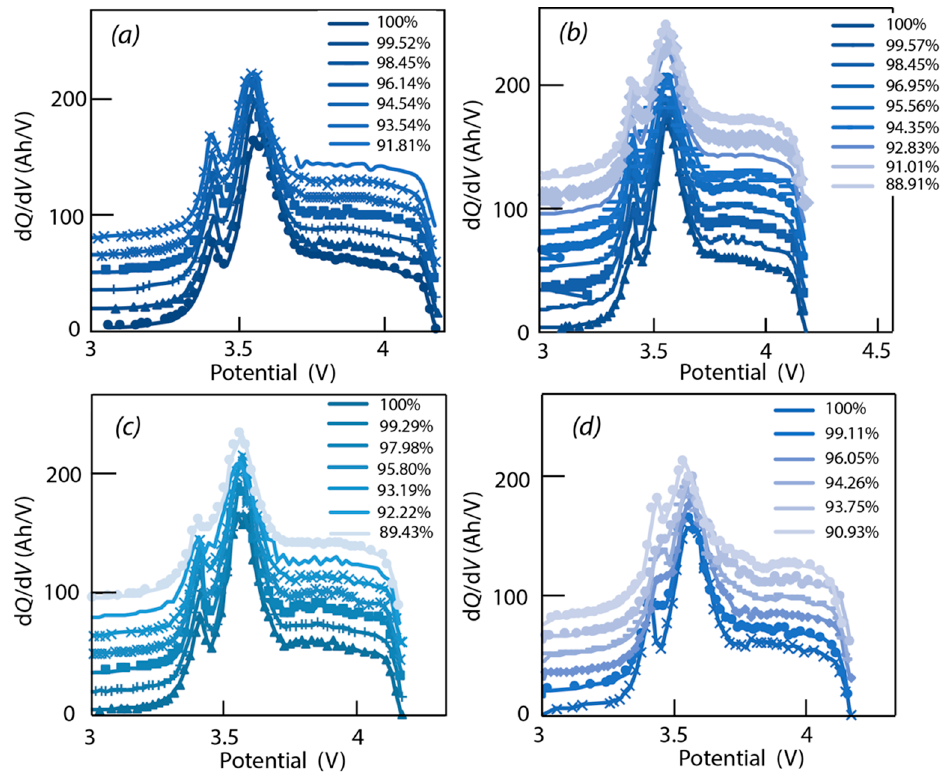
Figure 3. IC curves obtained for ( a ) (45°, SOC 50, 1C/1D), ( b ) (45°, SOC 30, 1C/1D), ( c ) (45°, SOC 15, 1C/1D), and ( d ) (45°, SOC 80, 1C/1D) at different states of health. A vertical offset was added for the sake of clarity: the curves have a 15 Ah/V-offset each.